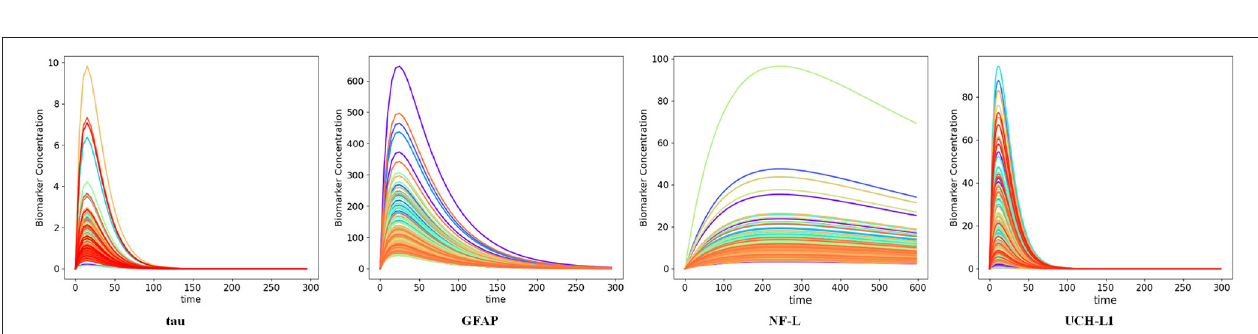
FIGURE 9 | Monte Carlo simulations to investigate the effect of uncertainty in total blood volume on the blood biomarker level ( C p ). Simulations set the model parameters to the nominal values in Table 1 and a biomarker release of 400,000 pg. Normal probability distributions with nominal values of 4,750 and 5,320 ml were used for women and men, respectively. (Top) Histograms for GFAP blood biomarker levels at 6 h for women. (Bottom) Histograms of tau blood biomarker levels at 6 h for men. Means and standard deviations for blood volumes from published estimates (64).